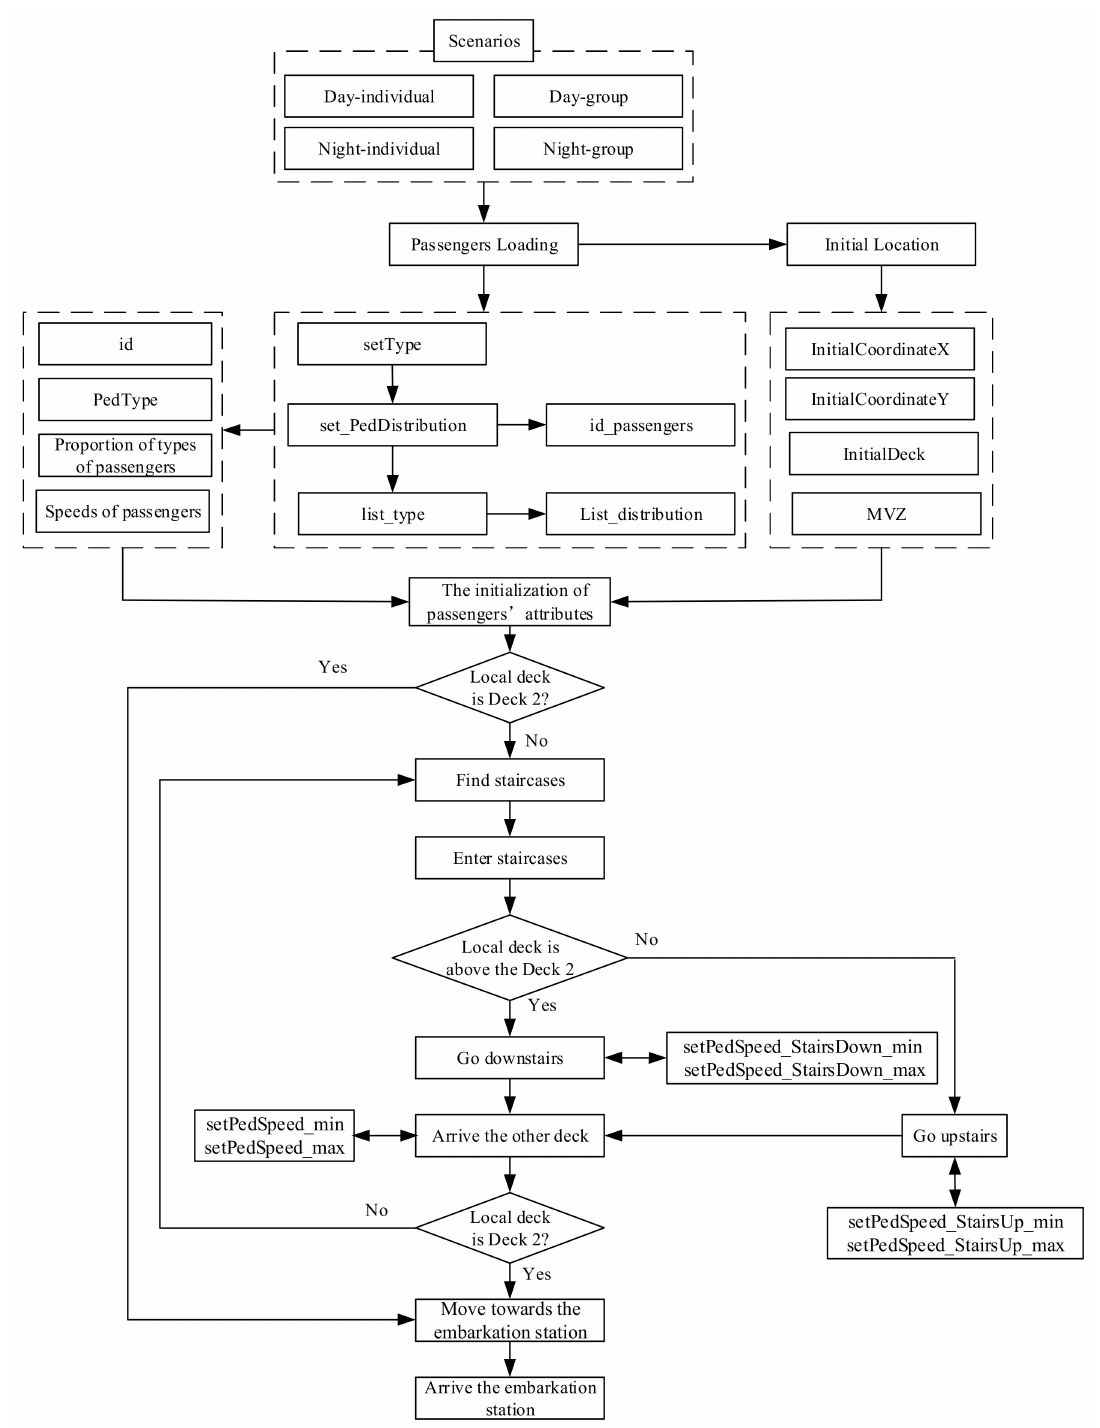
Figure 9. The simulation process of passenger